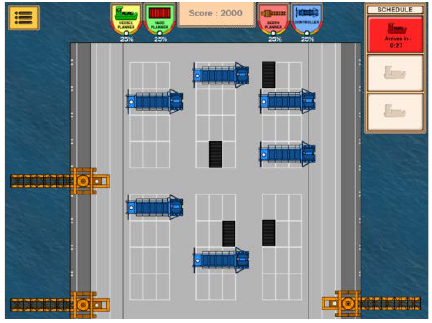
Figure 1. Screenshot of the YCS